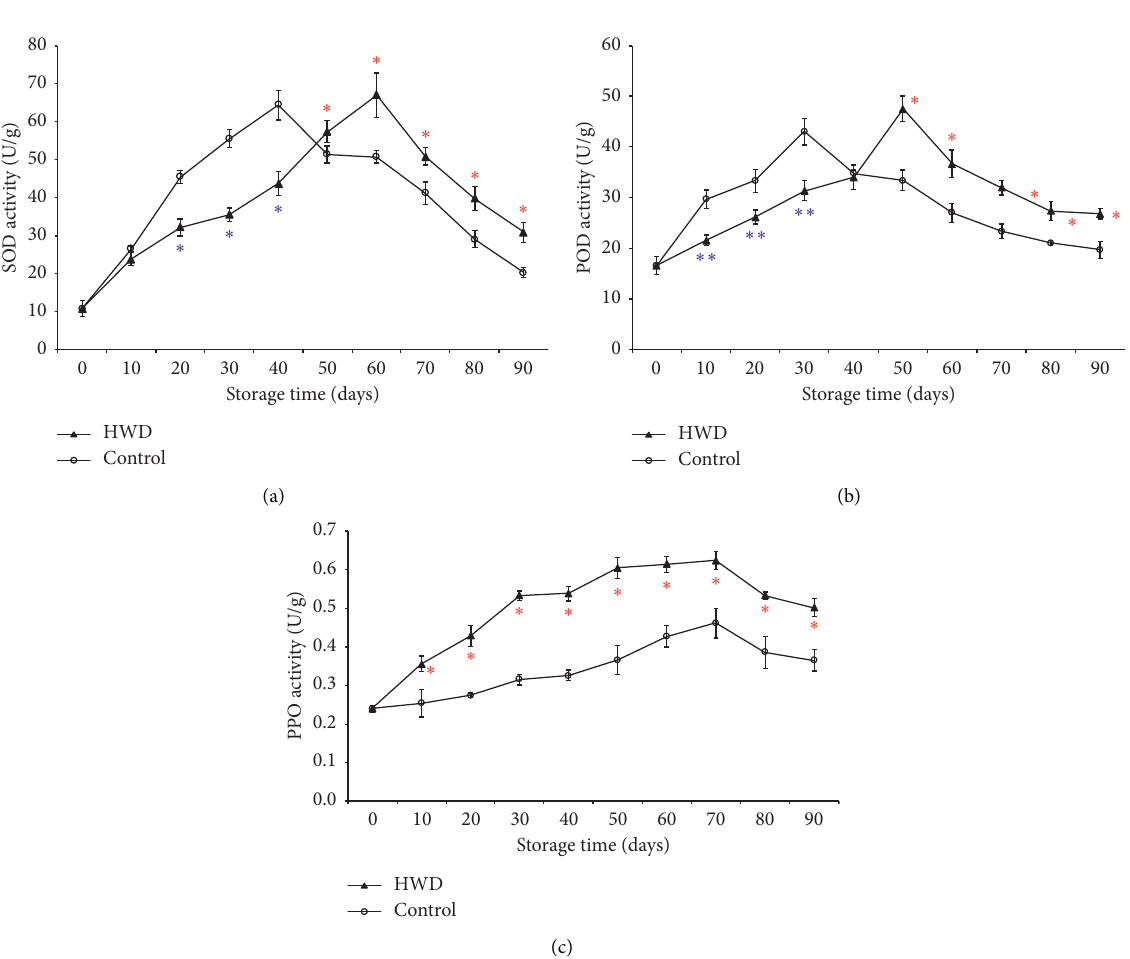
Figure 4: Effects of HWD on enzyme activities of SOD (a), POD (b), and PPO (c) of “Nanfeng” mandarin during 90 days of cold storage at 6 ° C. The symbols “ ∗ ” and “ ∗∗ ” represent significantly higher and lower values for the HWD-treated fruits than the control fruits, re- spectively. The significant difference was determined according to the independent-samples t -test ( P < 0 . 05) on each storage